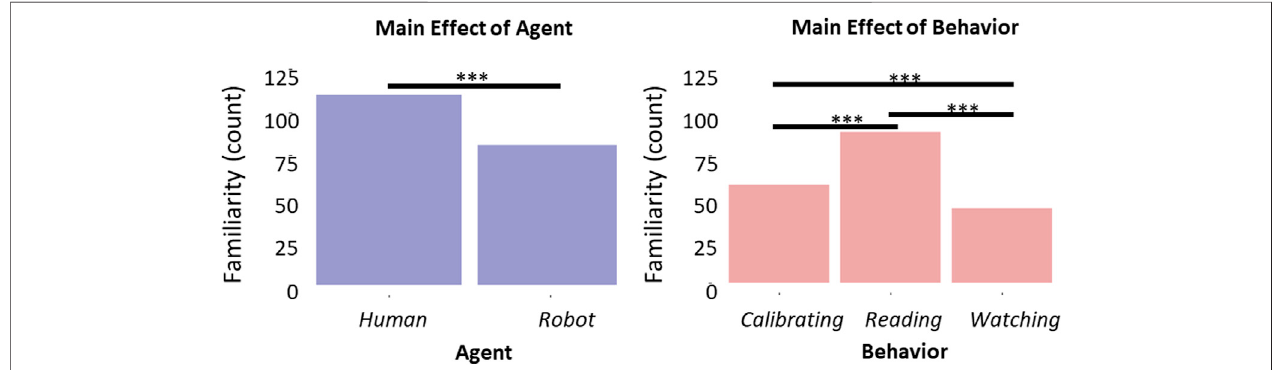
FIGURE 6 | Histograms representing participants ’ familiarity with the Agent (A) and with the Behavior (B) . Horizontal bars denote differences surviving post hoc comparison, asterisks de fi ne the level of signi fi cance of the comparison (* p < 0.05, ** p < 0.01, p < 0.001).